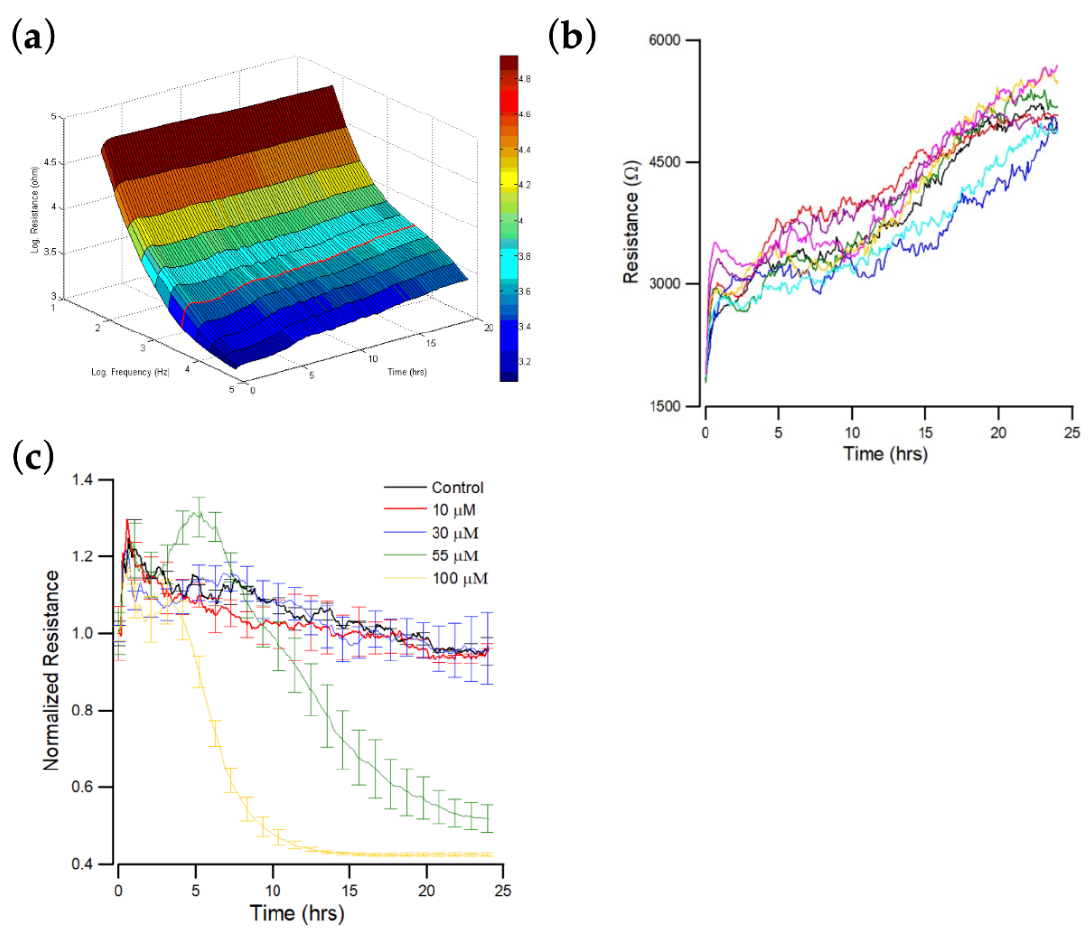
Figure 3b, the normalized resistance spectra display as biphasic curves, with a peak value at 4 kHz.